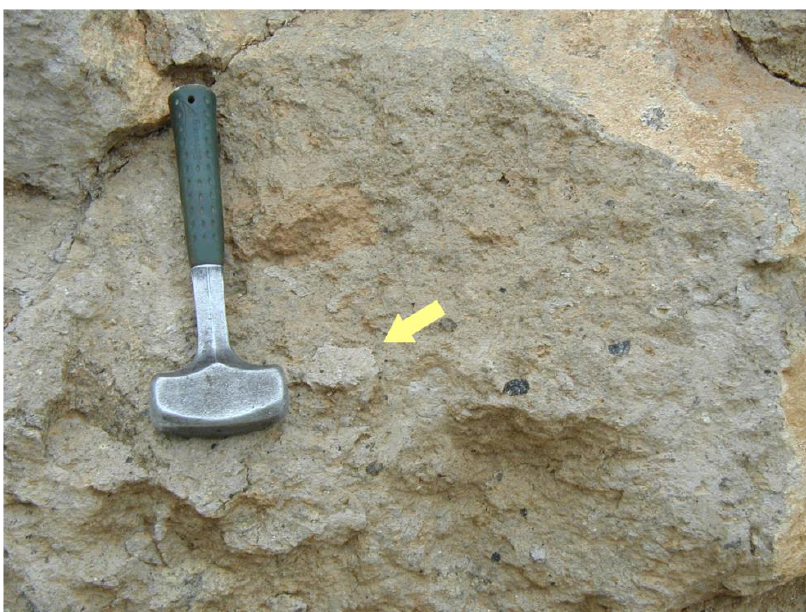
Figure 2. Papagayo Tuff in outcrop near the base of 23-m section exposed at Bahía Culebra. The yellow arrow indicates a gray pumice fragment in the